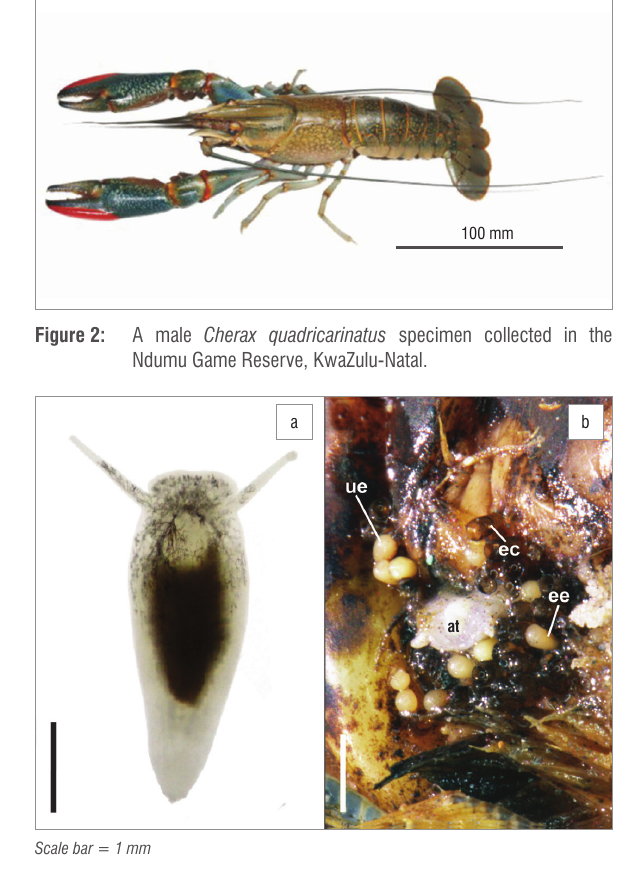
Figure 3: Images of (a) a live Diceratocephala boschmai and (b) an adult specimen, eggs and empty egg capsules of D. boschmai on the ventral surface of Cherax